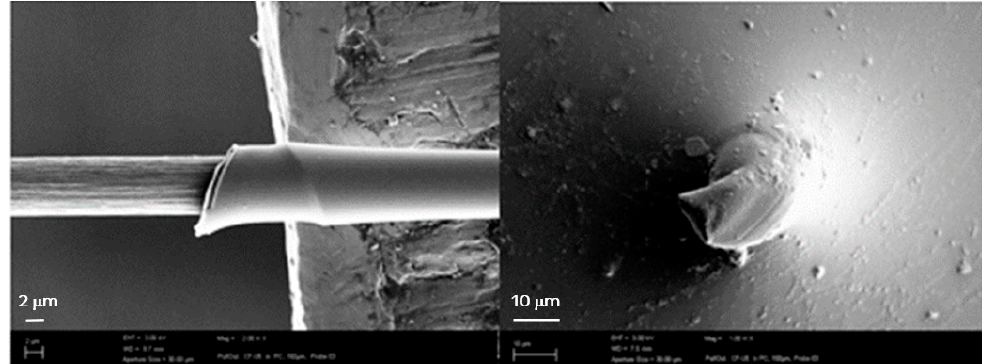
Figure 6. Stretching/yielding of the meniscus after pull-out testing; SEM image of the remaining